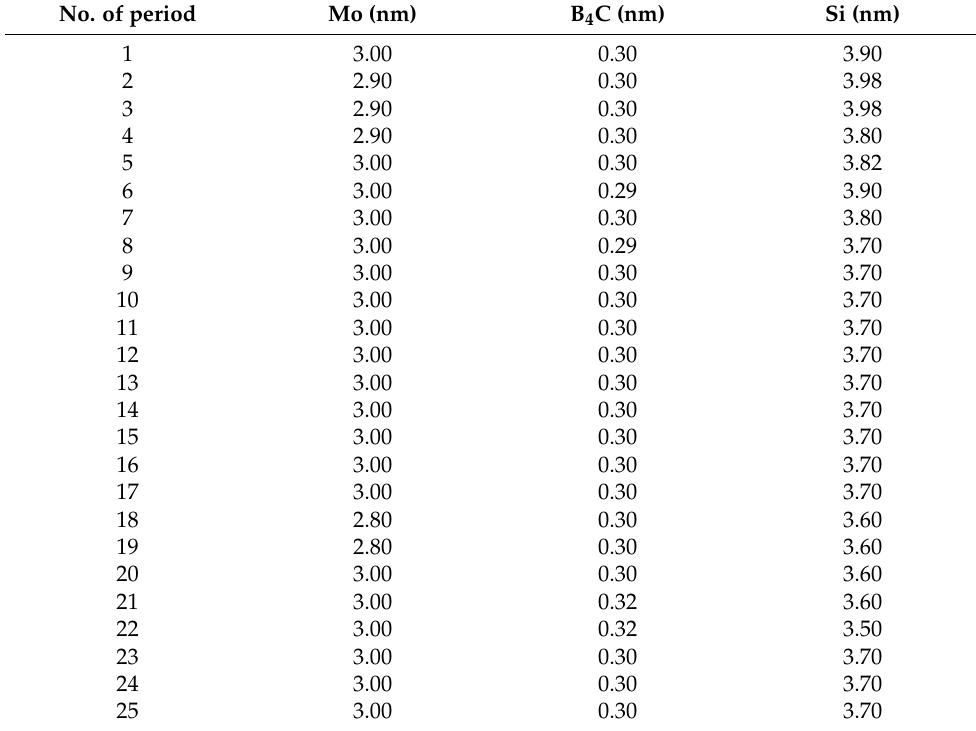
Table 3. The determined individual layer thickness by fitting the measured GDOES depth profiling data of the Mo/B 4 C/Si